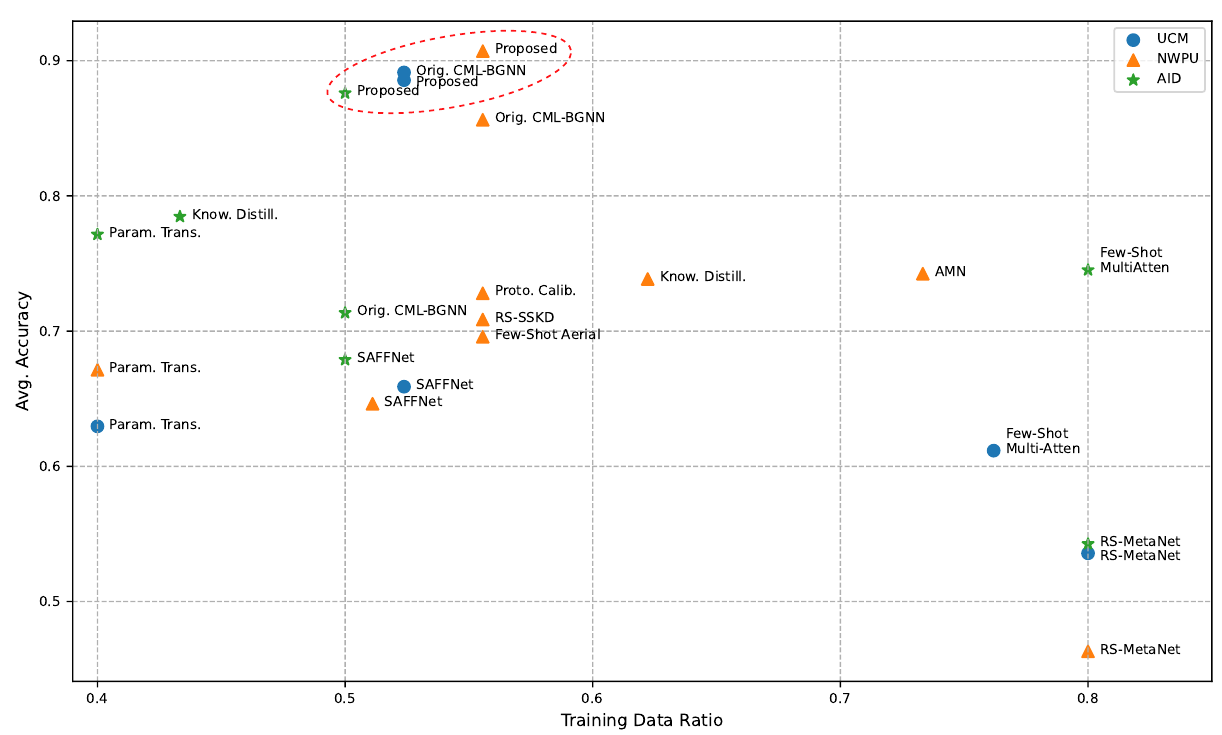
Figure 9. Data-to-knowledge transition efficiency comparison scatter plot. The positions of proposed algorithms are marked with red dashed